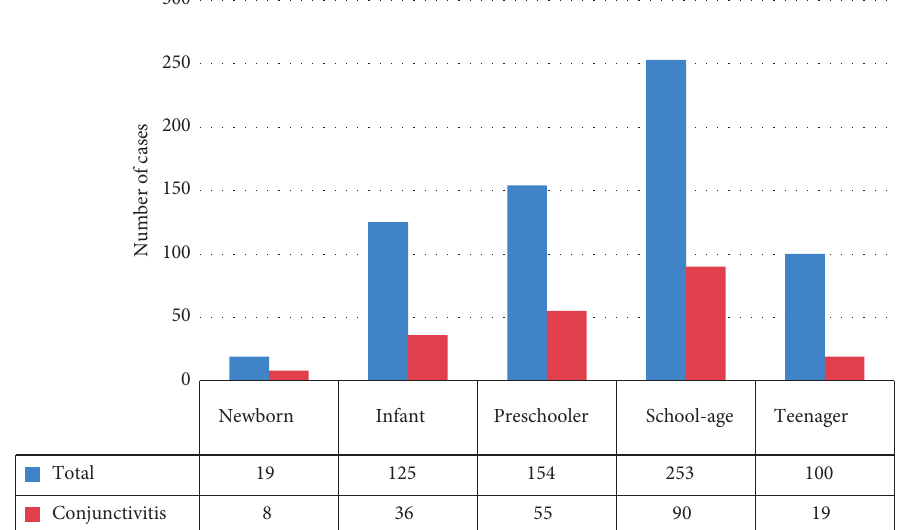
Figure 6: Age distribution for